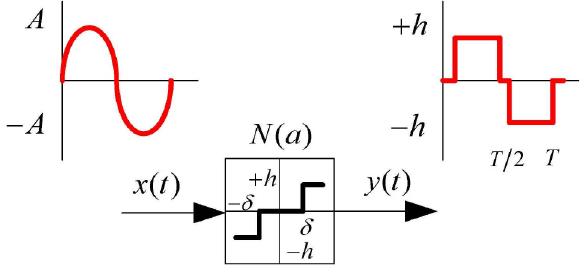
Figure 20. The diagram of the relay with dead zone.